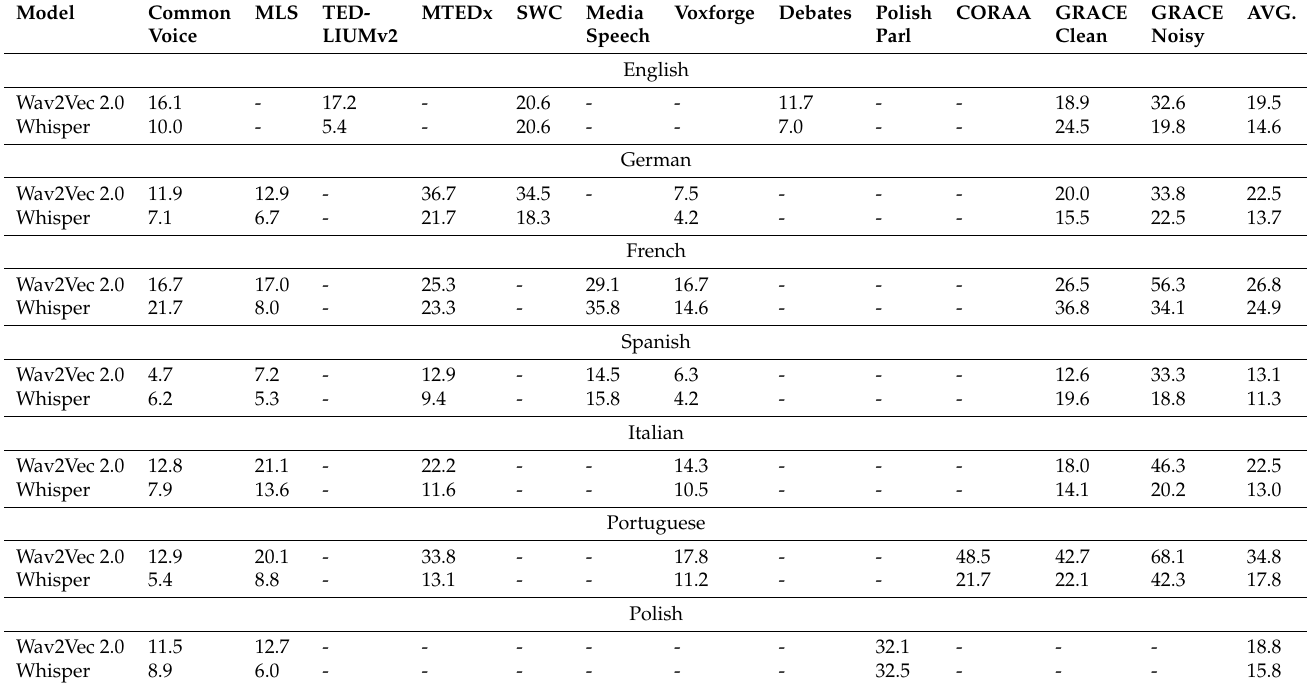
Table 3. Results of the ASR models in different languages considering all benchmark datasets. Results in terms of